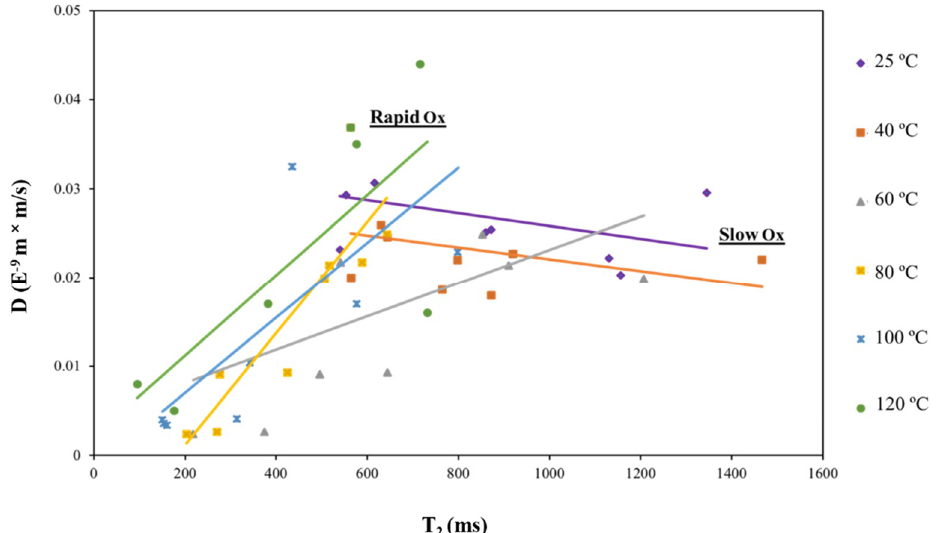
Figure 14. Correlation between LSO self-diffusion (D) and tail T 2 at 25, 40, 60, 80, 100 and 120 ◦ C during 168 h. The points of each applied temperature (different color) represent the distribution of D-T 2 values in each time tested along the 168 h and the best straight line for each oxidation temperature is drawn. (25 and 40 ◦ C designated as Slow Ox, and 60, 80, 100 and 120 ◦ C designated as Rapid Ox). Reprinted with permission from ref. [34]. Copyright 2019 Wiley.